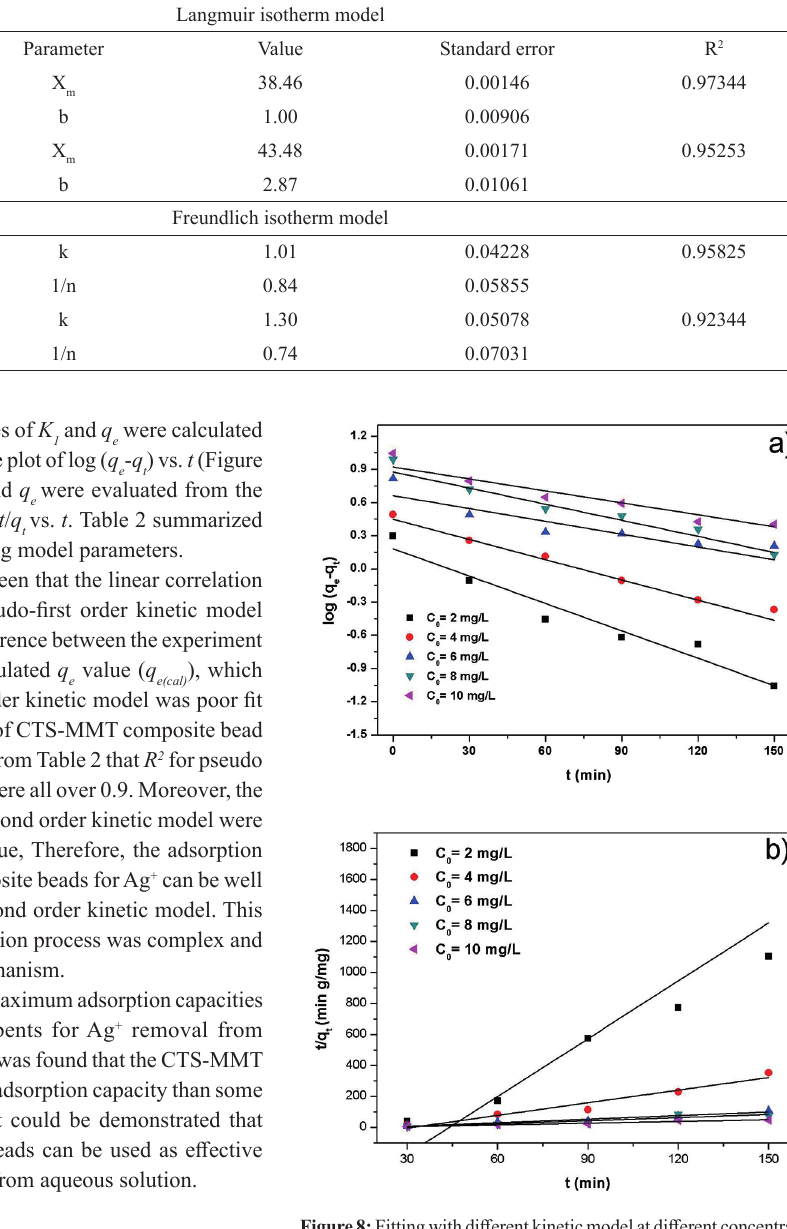
Figure 8: Fitting with different kinetic model at different concentration (a) Pseudo-first-order model, and (b) Pseudo-second-order model for CTS-3%MMT composite